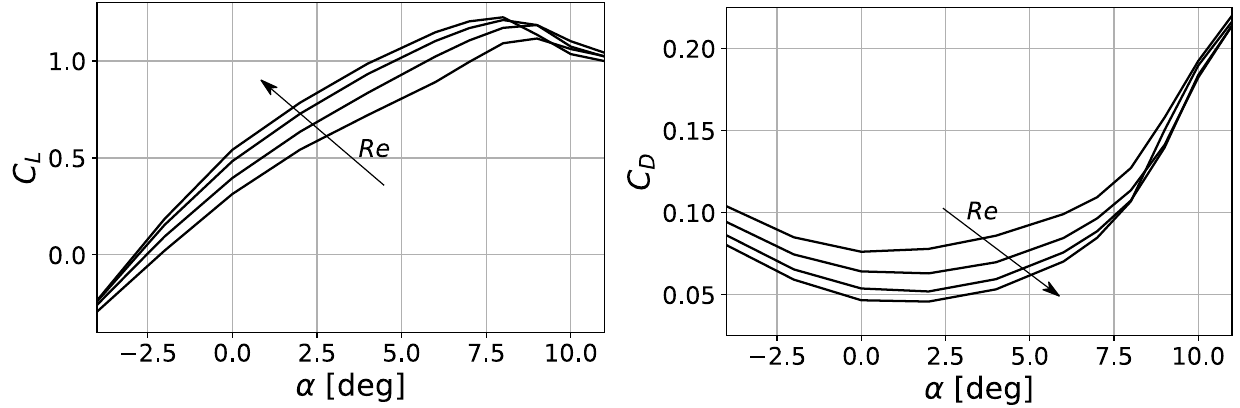
Figure 6. C L and C D of the used airfoil at variable Reynolds numbers and angles of